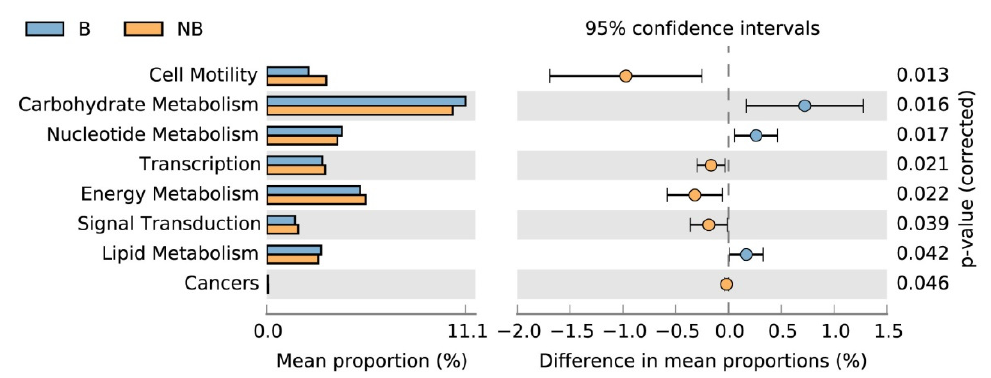
Figure 5. The extended error bar for significant differences in the second level of functional categories of the KEGG pathways. The color of the dots indicates that this pathway is significantly enriched during this period ( p < 0.05). B, breeding season; NB, non-breeding season.